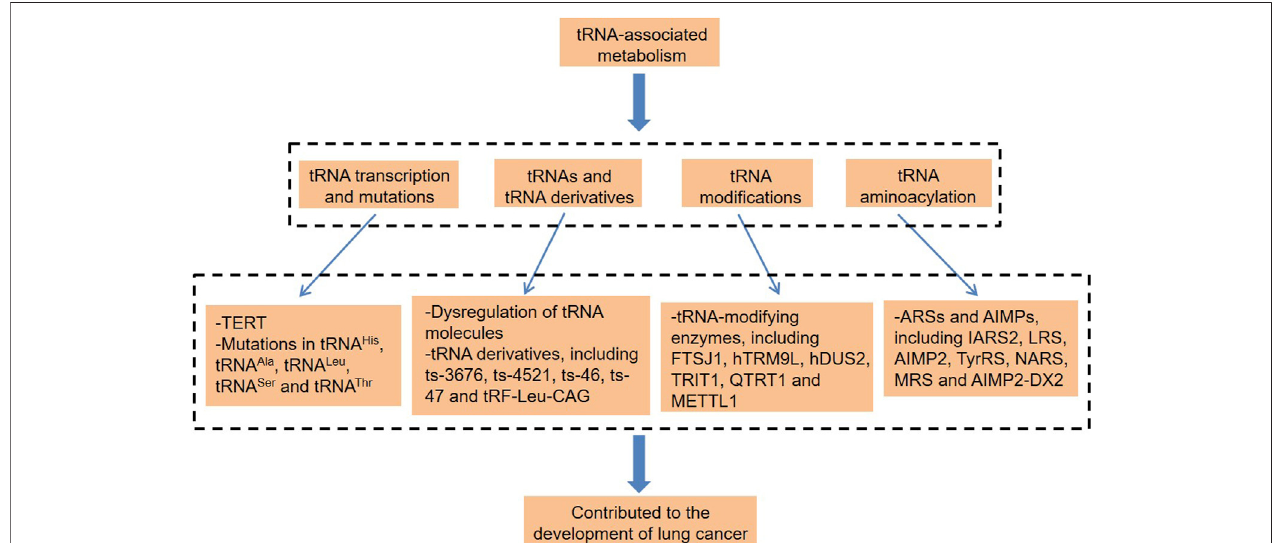
FIGURE1| tRNA-associated metabolism and lungcancer.tRNA,transferRNA;TERT,telomerase reversetranscriptase;hTRM9L,tRNA methyltransferase 9-like; TRIT1, tRNA isopentenyltransferase 1; QTRT1, tRNA-ribosyltransferase 1; METTL1, methyltransferase-like 1; ARSs, aminoacyl-tRNA synthetases; AIMPs, ARS- interacting multifunctional proteins; IARS2, isoleucyl-tRNA synthetase 2; LRS, leucyl-tRNA synthetase; TyrRS, tyrosine-tRNA synthetase; NARS, asparaginyl-tRNA synthetase; MRS, methionyl-tRNA synthetase; and AIMP2-DX2, AIMP2 lacking exon 2.